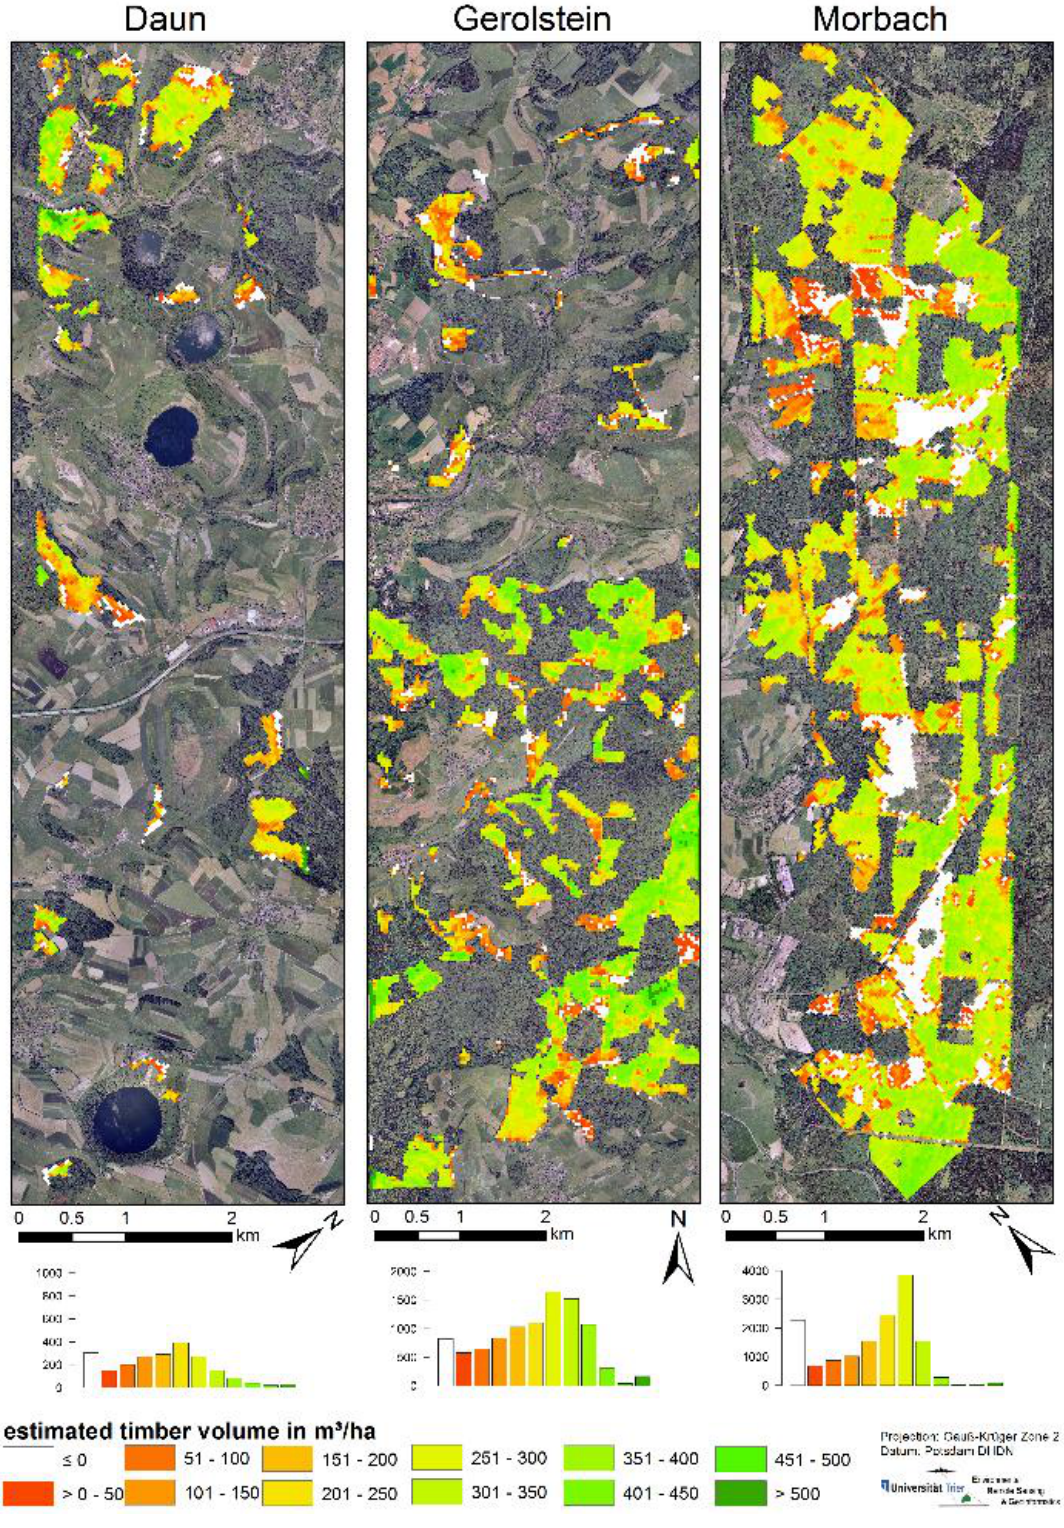
Figure A1. Timber volume prediction map based on PLSR with simulated EnMAP